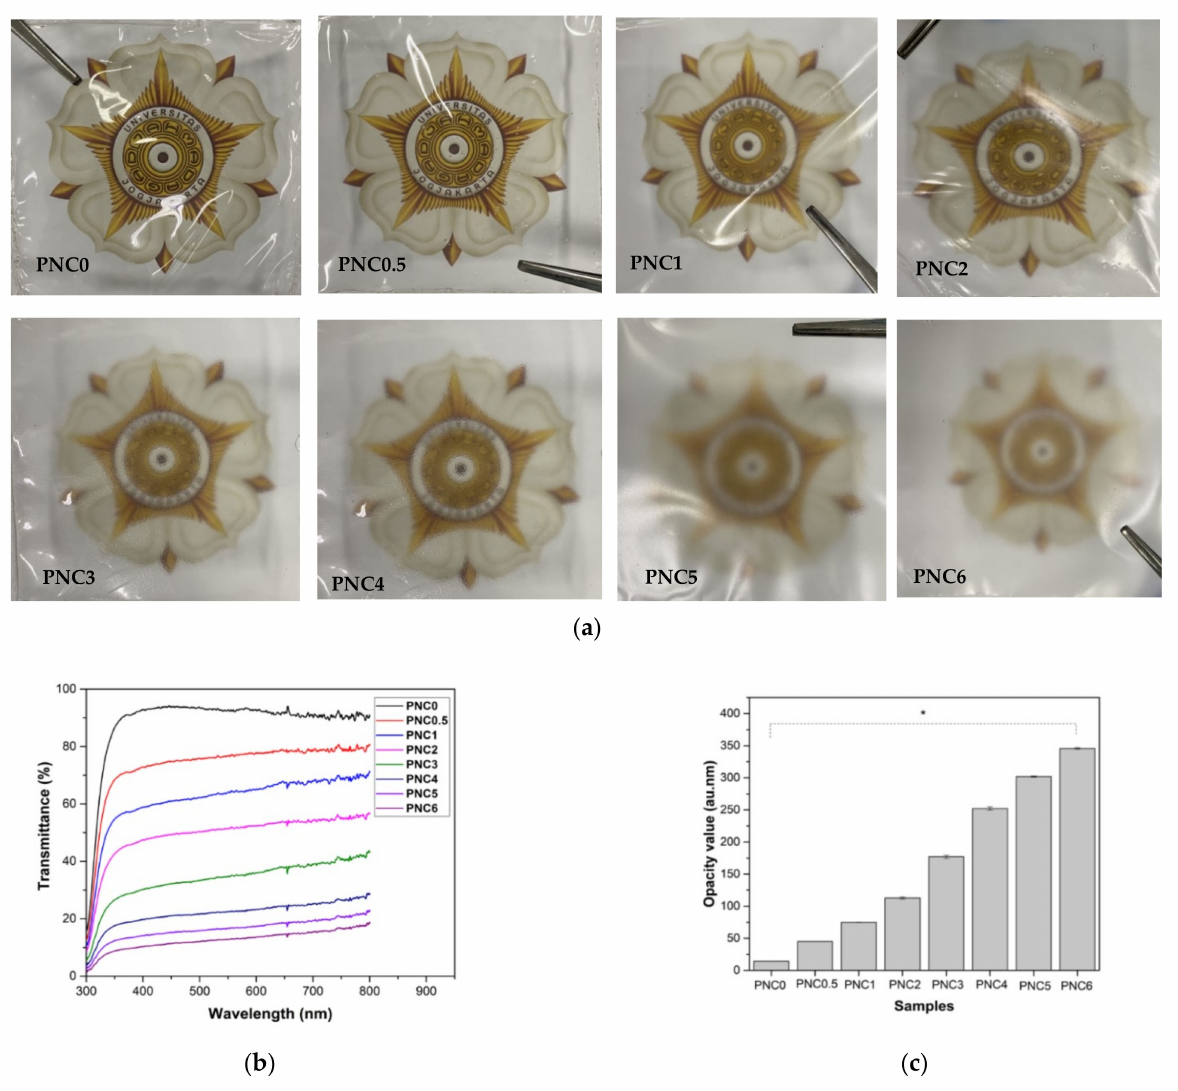
Figure 8. ( a ) Images of PVA–NCC nanocomposite films. ( b ) The transmittance values of PVA–NCC nanocomposite films. ( c ) The opacity values of PVA–NCC nanocomposite films (*: p <